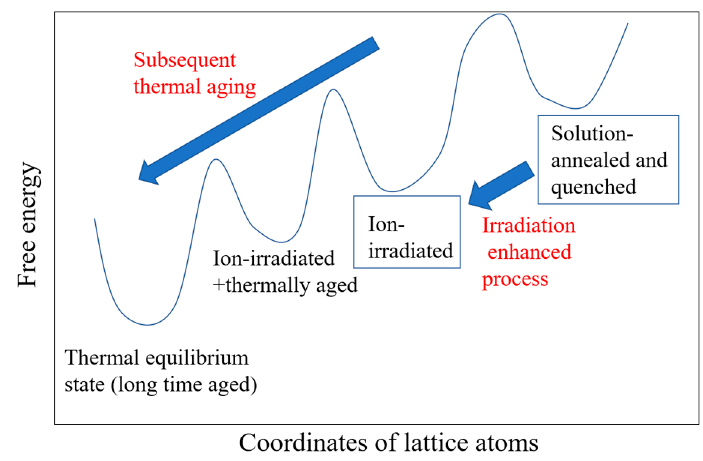
Figure 14. Schematic diagram of change in free energy for “irradiation-enhanced process” and subsequent thermal aging.